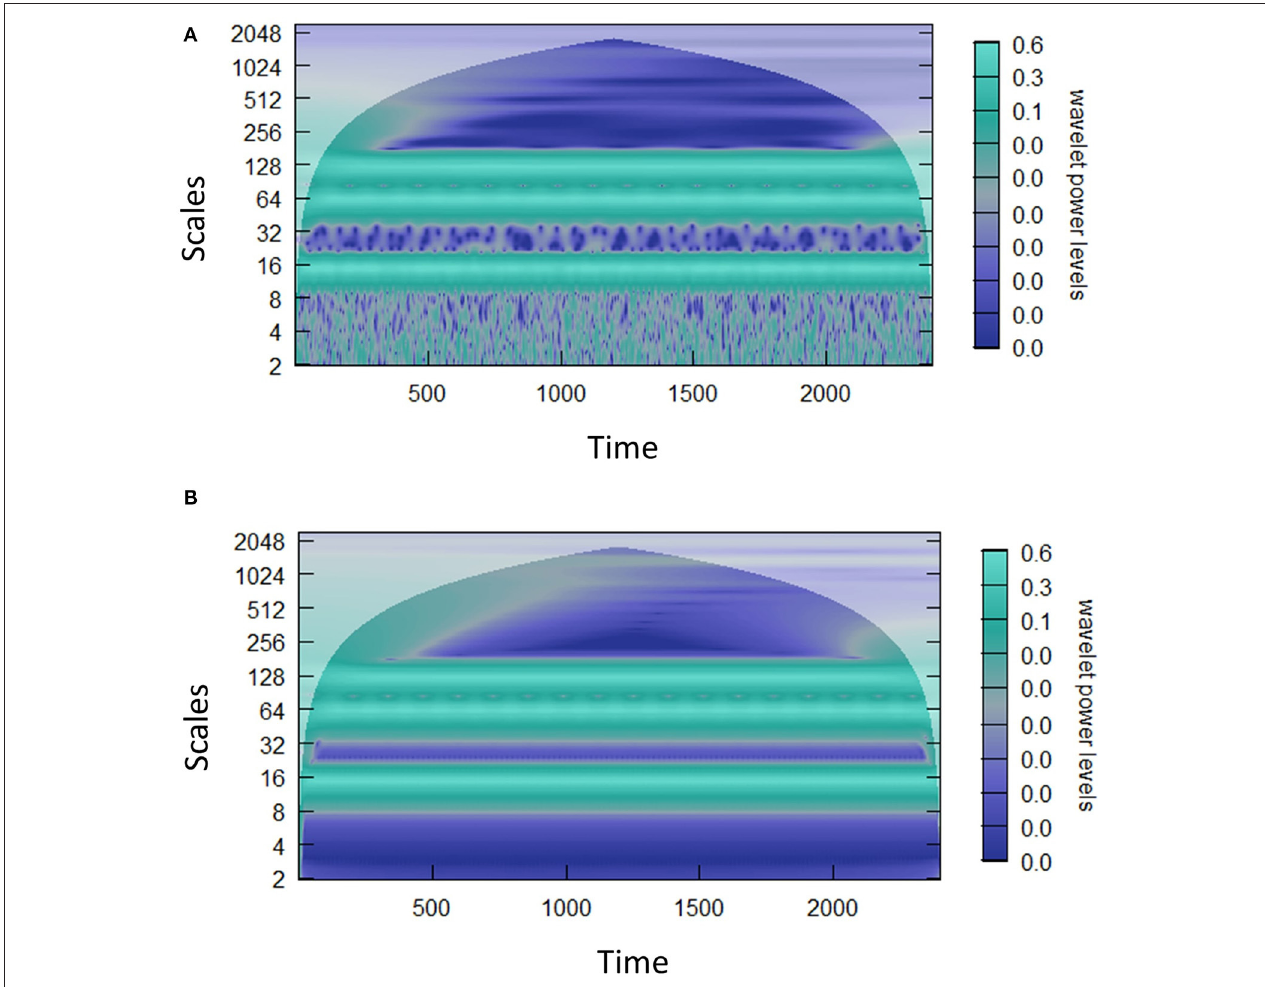
Figure A1 | Additive noise Model. Pure signal. The CWT power spectrum (A) of a simple additive noise model with three stationary signals. Biweekly (15 days), quarterly (64 days), and biannually (125 days). Hence we have that y